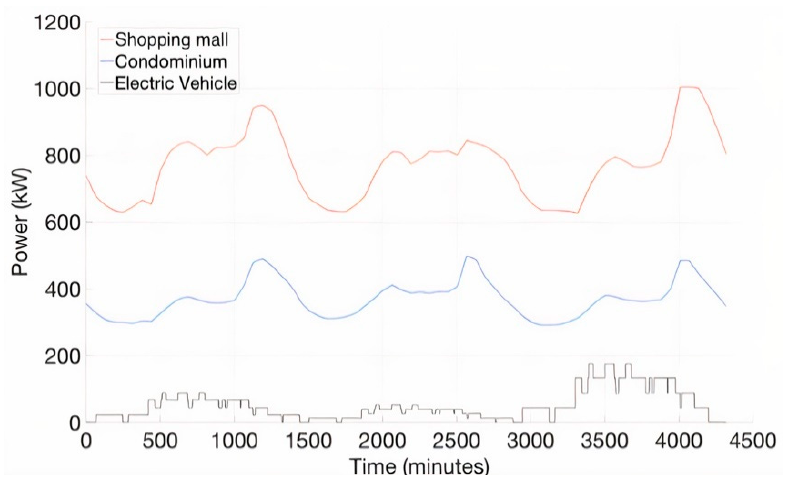
Figure 5. Electricity demand (13.8 kV).